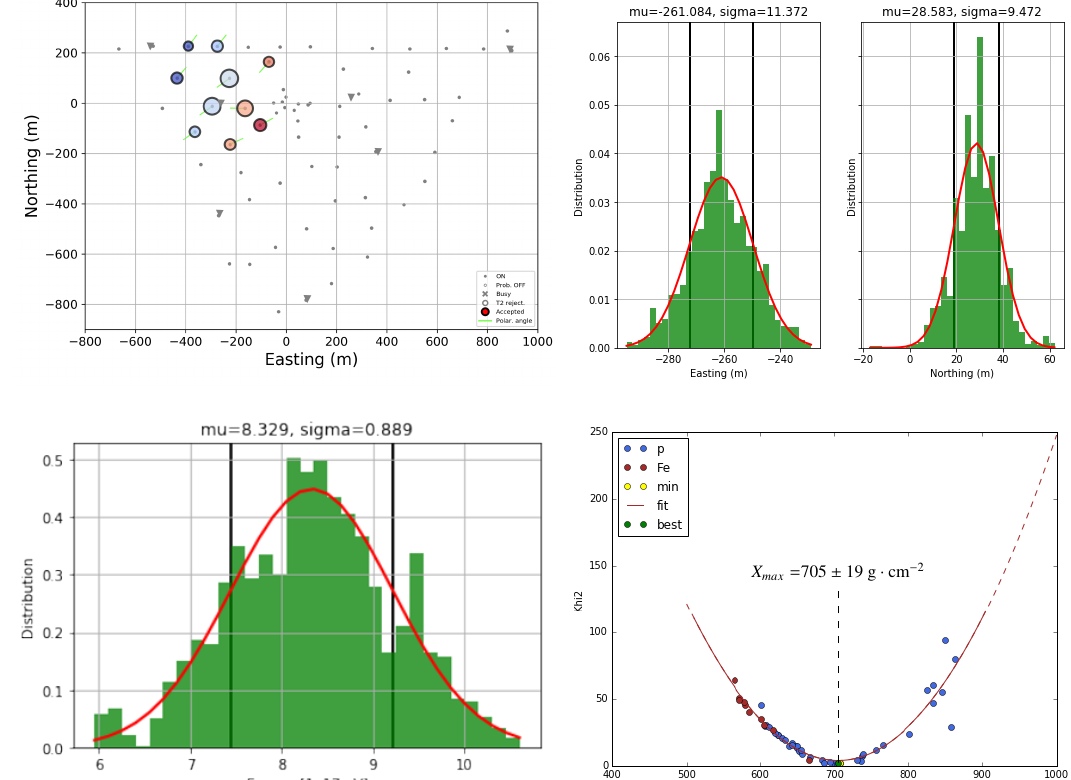
Figure 5: Reconstruction of an event detected by CODALEMA. The ground footprint is on the top left figure. The involved standalone antennas are represented by coloured circles, whose colour indicates the timing order in which the signal has been seen by the antennas (from blue, earliest, to red, latest) and size reflects the relative amplitude of the signal (linear scale). The other plots indicate the accuracy on the shower parameters. The red curve is a Gaussian fits of the distributions, the black vertical lines represent the 1 σ confidence level. The distributions are obtained by propagating the uncertainties on the measured values of the electric field. See text for more